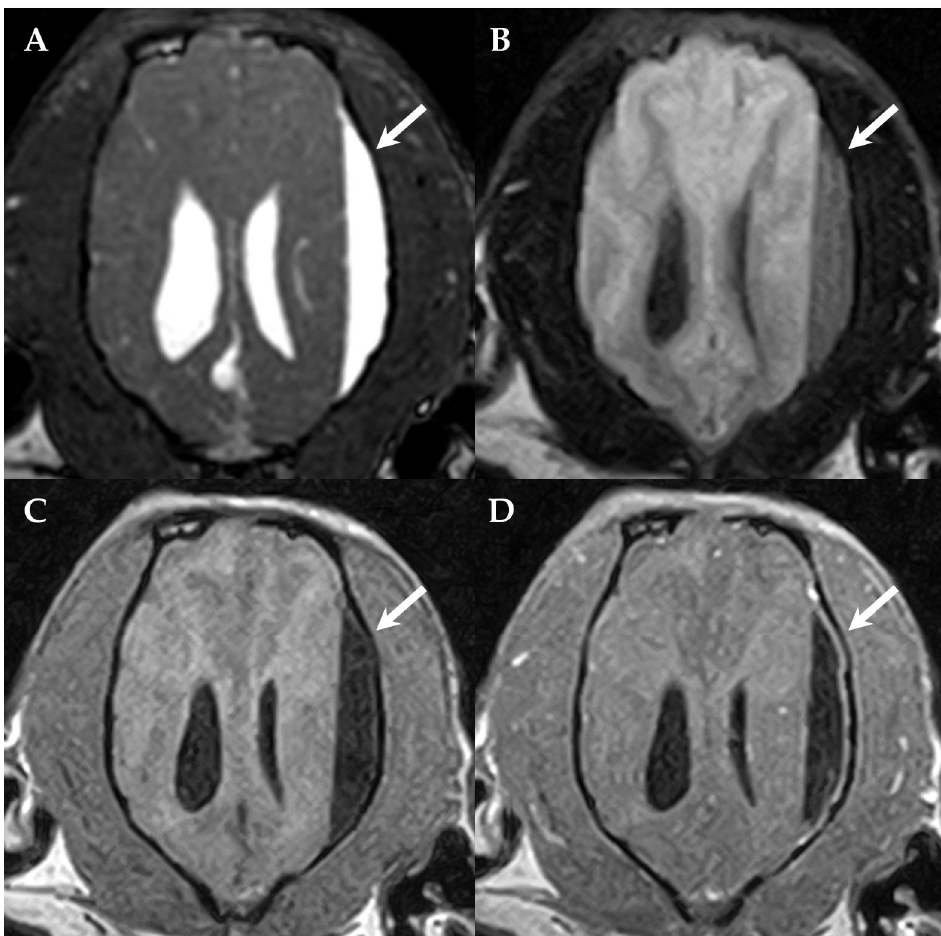
Figure 1. First MRI of the dog’s brain. Dorsal BASG ( A ), FLAIR ( B ) 3DT1W ( C ) and 3DT1W after contrast administration ( D ) showing the subdural fluid accumulation (SFA, arrows) compressing the left parietotemporal lobe and the left lateral ventricle. The SFA is BASG hyperintense ( A ), incompletely compressing on FLAIR ( B ), 3DT1W hypointense and demonstrates a mild contrast-enhancement of the adjacent dura mater ( D ). The left side of the patient is on the right side of the